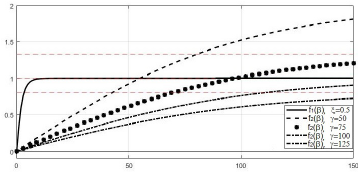
Figure 5. Graphics of the function f 1 ( β ) for ξ = 0 . 5 and function f 2 ( β ) for h = 0 . 02 and various γ . The existence of the root β 0 of Equation (2.8) depend of γ